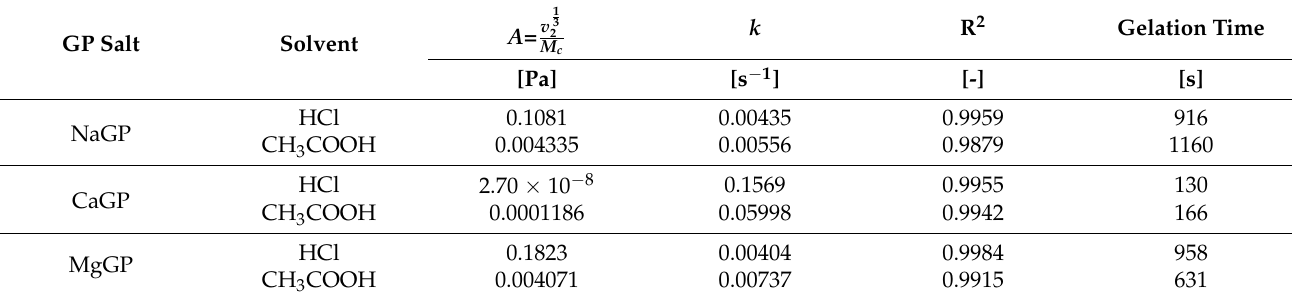
Table 2. Values of parameters A and k of Equation (1) and the gelation